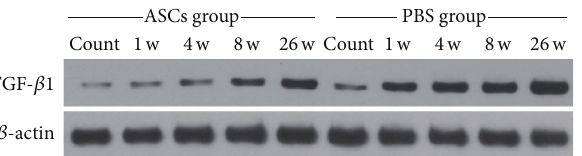
Figure 8: Western blot analysis of the expression of TGF- 𝛽 1 in muscletissueatdifferenttimepointsafterirradiation.Similarresults were obtained in three independent experiments. Representative data are